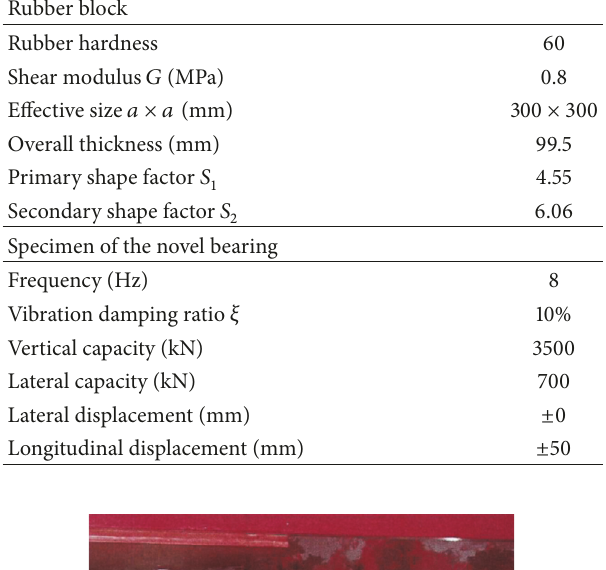
Table 1: Design parameters of the specimen of the novel bearing.